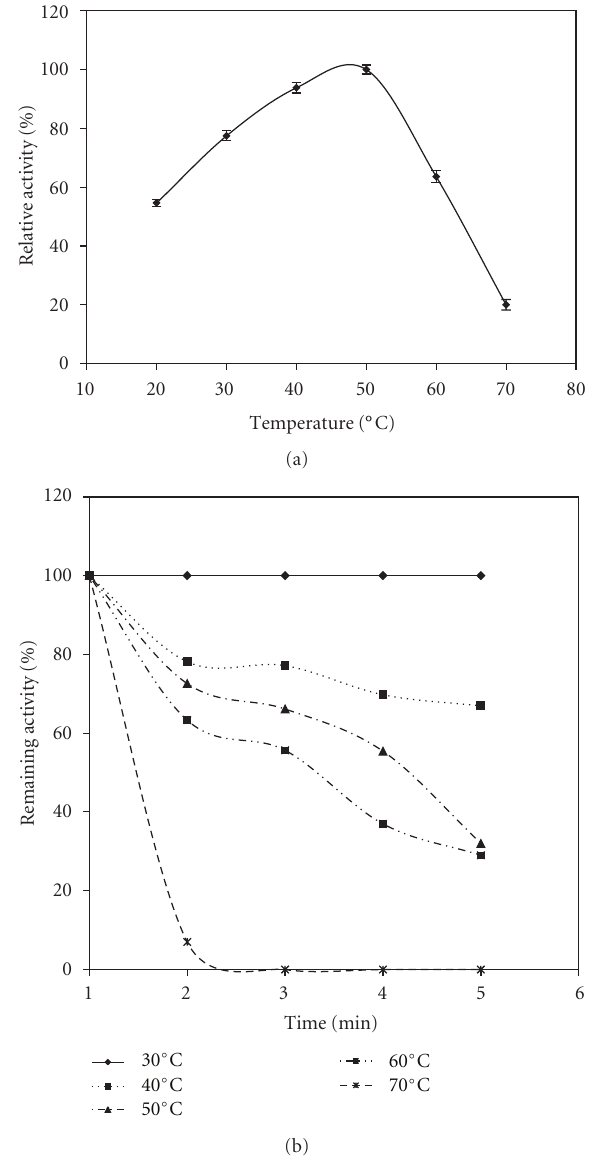
Figure 5: E ff ect of temperature on the activity (a) and stability (b) of the extracellular proteinases of A. niger I1. The temperature profile was determined by assaying proteolytic activity at tempera- tures between 30 ◦ C and 70 ◦ C. The activity of the enzyme at 50 ◦ C and pH 4.0 using hemoglobin as a substrate was taken as 100%. The temperature stability was determined by incubating the crude enzyme in di ff erent temperature for 1h, and the residual activity was measured at pH 4.0 and 50 ◦ C with hemoglobin as a substrate. The nonheated enzyme was considered as 100%